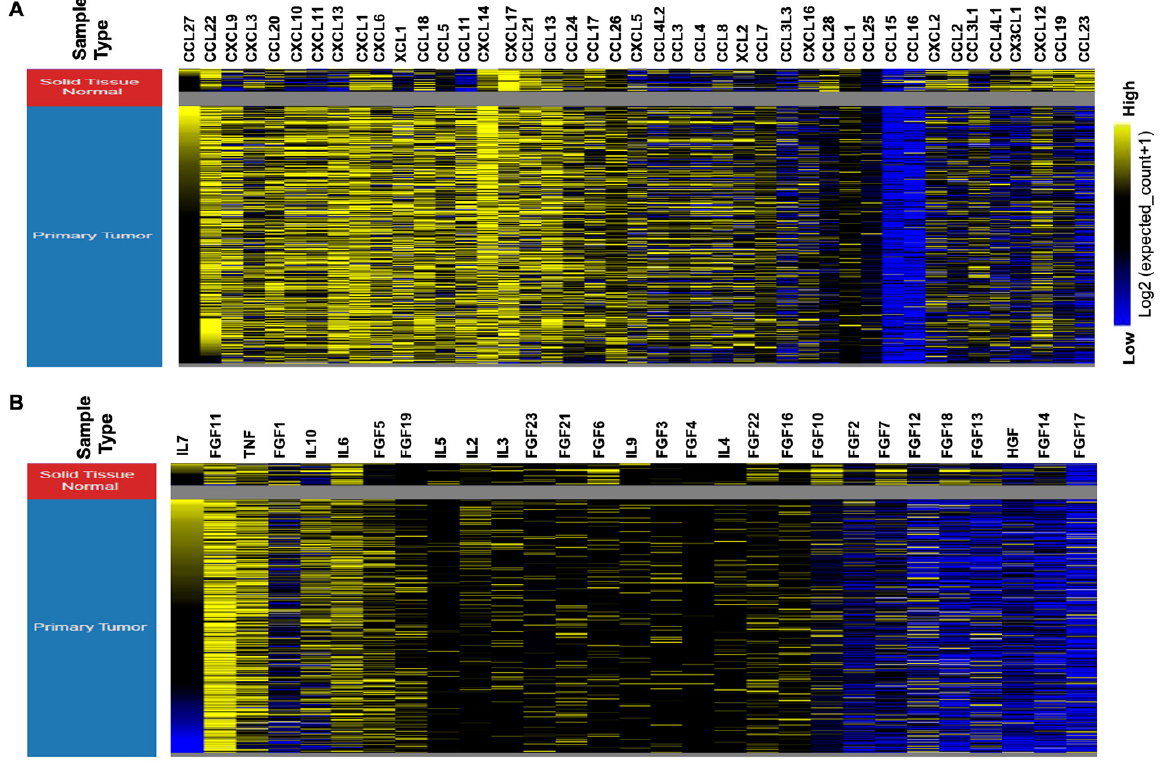
Figure 2. Deregulated chemokines and cytokines in HNSCC. The heat maps showing deregulated expression of ( A ) chemokines and, ( B ) cytokines in HNSCC patients. The heat maps were constructed through data mining in the HNSCC TCGA database by using the UCSC Xena browser (http://xena.ucsc.edu) (adjacent normal, n = 44, tumor tissue, n = 518 and metastatic = 02) samples).